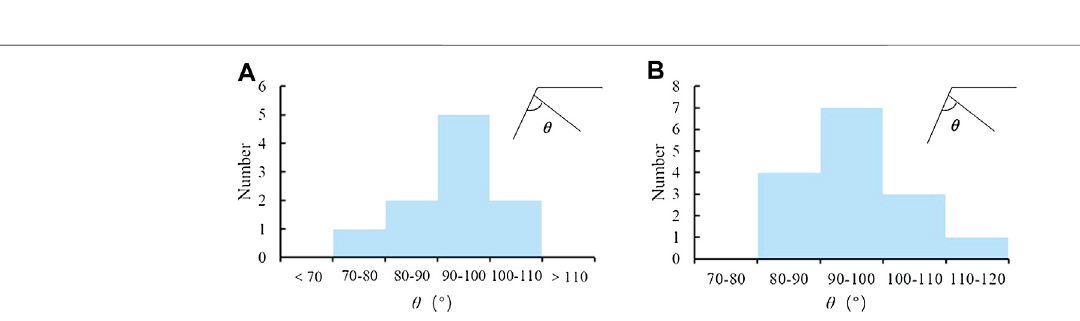
Frontiers in Earth Science |